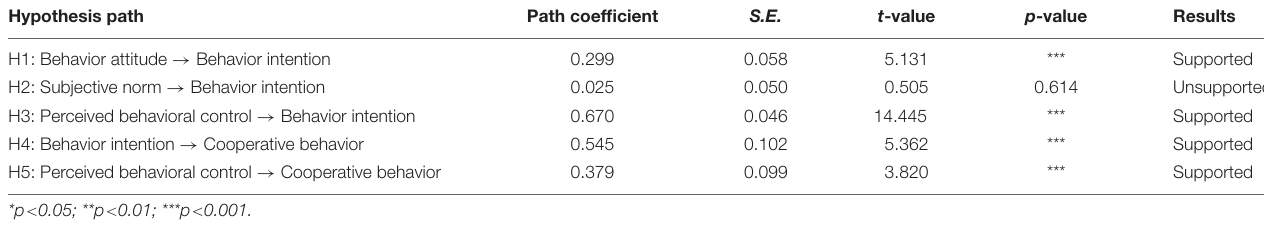
TABLE 7 | Results of mediating effect